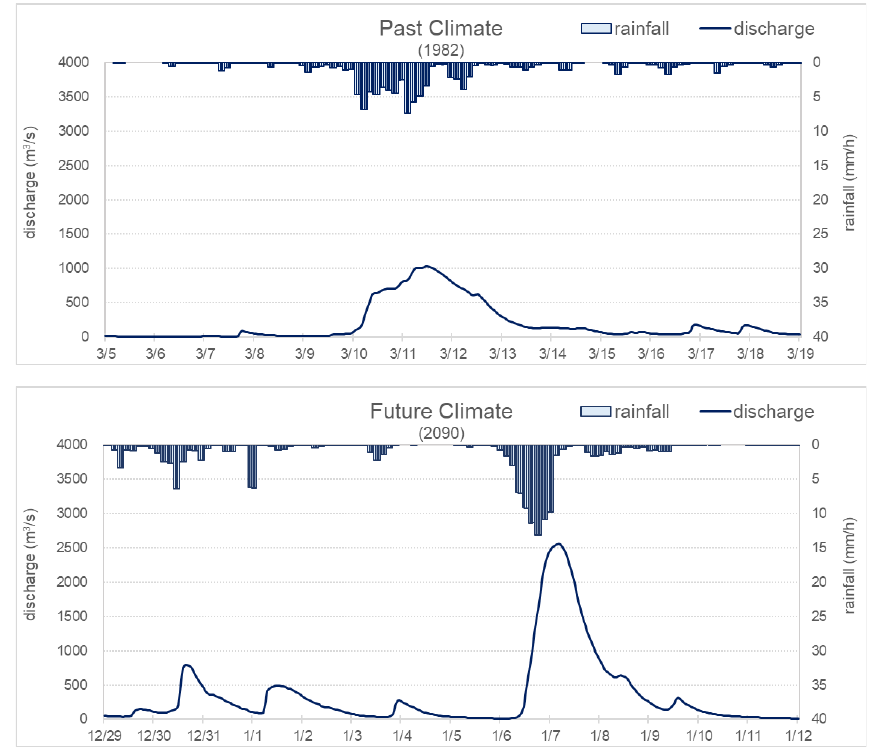
Figure 7. Results of river discharge at the upstream end of the focus area during the worst flood events for the past ( upper ) and future ( lower ) climate, simulated by the basin-scale model. The peak discharge in the future is about 2.5 times that of the past. These time series of river discharge were applied to the barangay-scale model as the boundary condition.